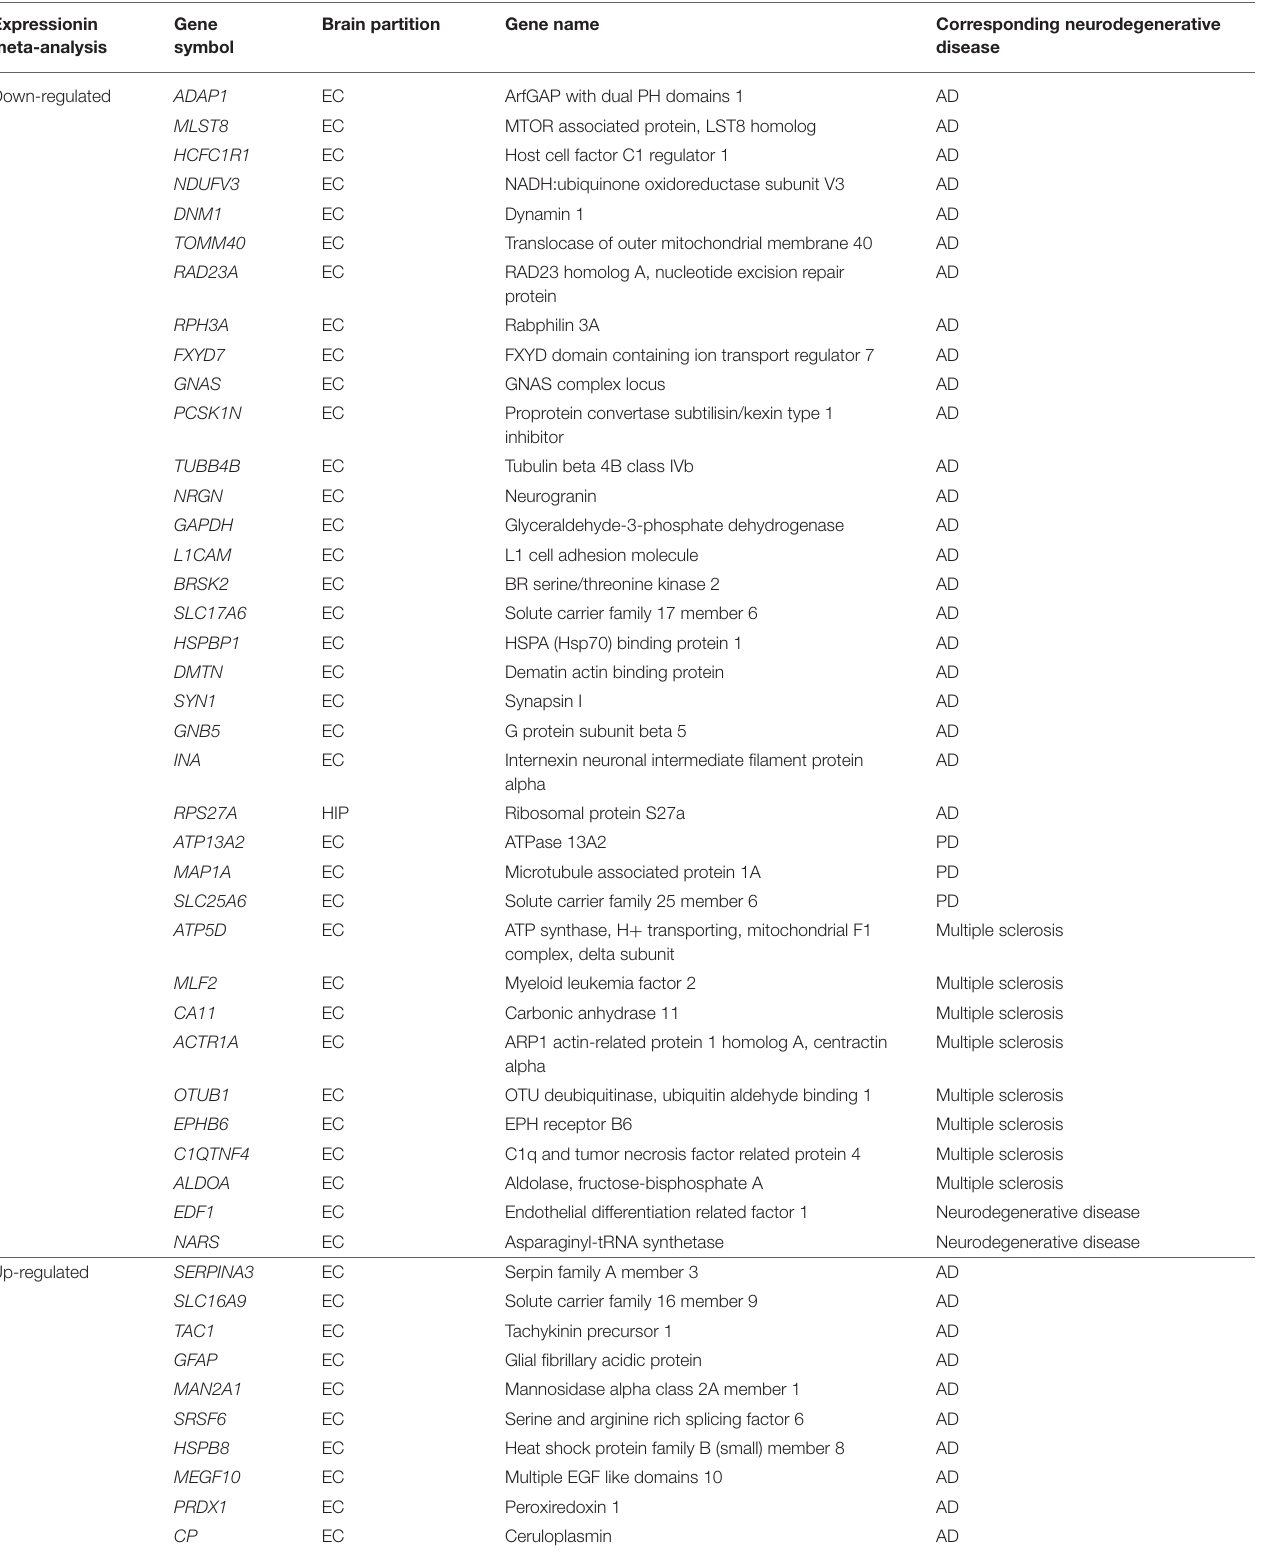
TABLE 4 | AD and other neurodegenerative diseases associate genes identified from DEGs using GCBI online software. Expressionin